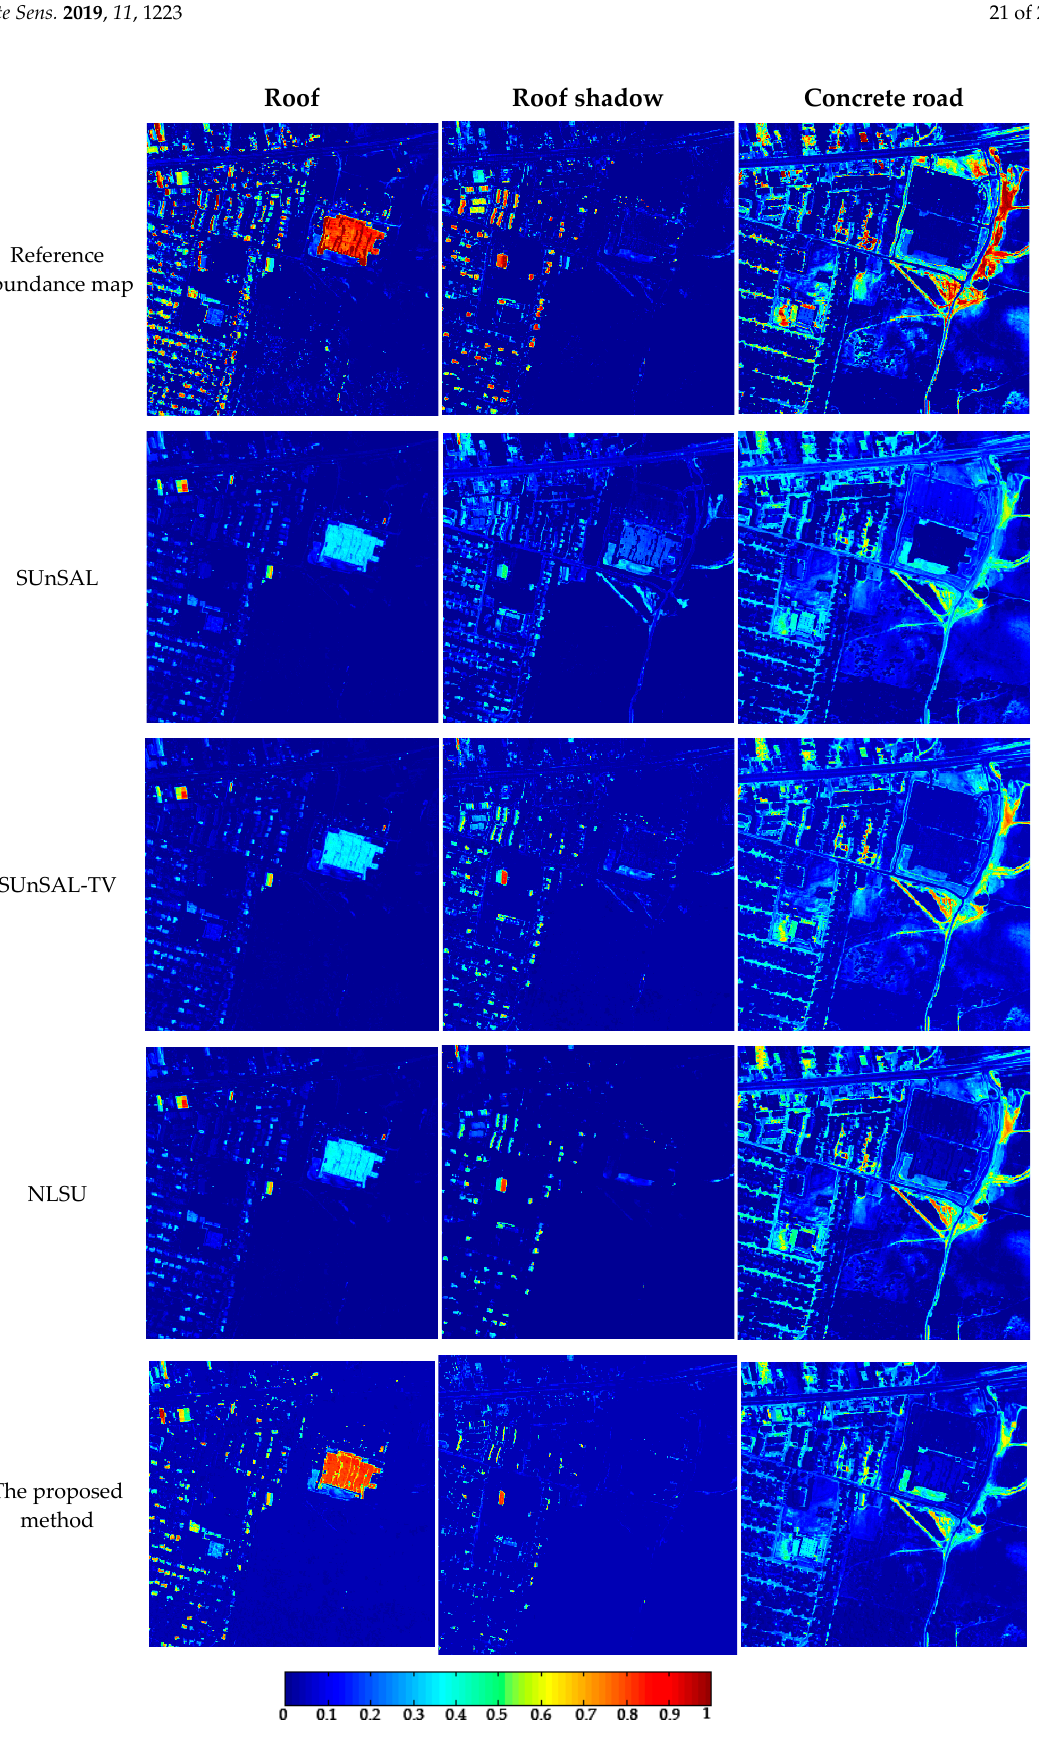
Figure 12. Unmixing results for R-2.